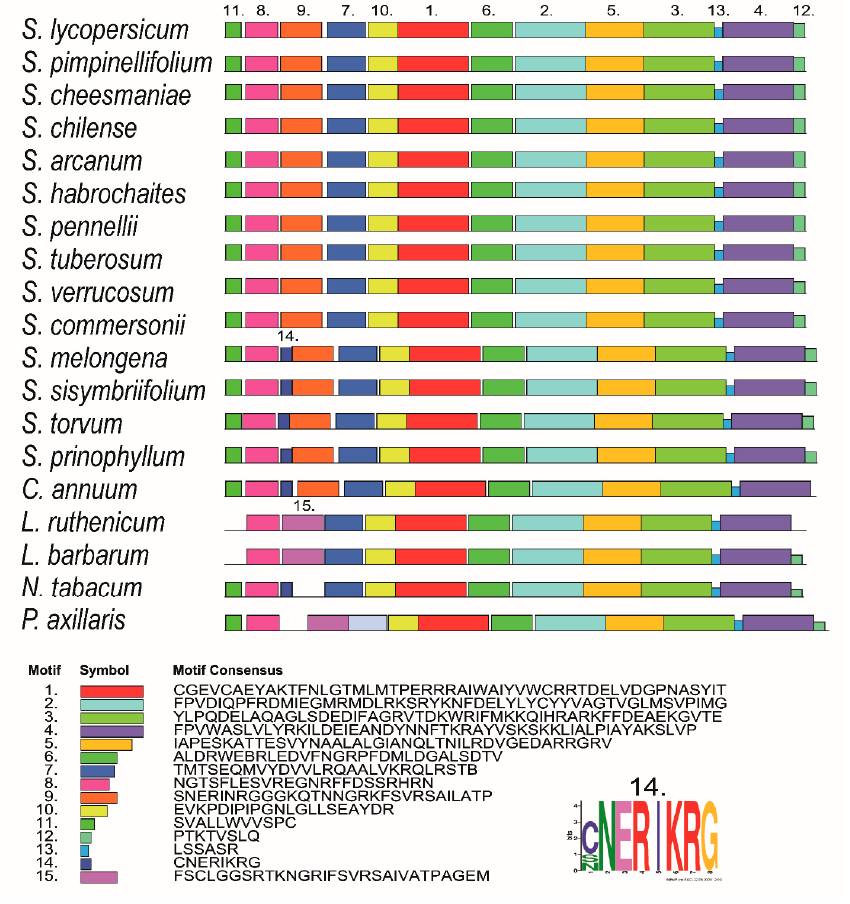
Figure 3. Distribution of conserved motifs in PSY1 homologs of Solanaceae species identified using the MEME search tool. The length of each box corresponds to that of the motif; the order of the motifs corresponds to their position in each protein.